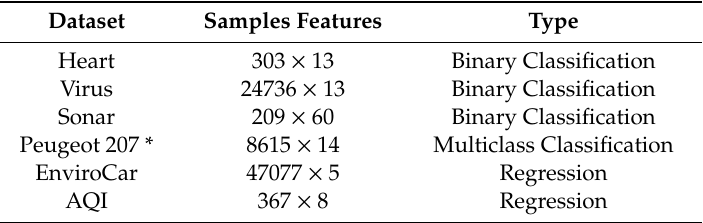
Table 4. Dataset specifications.